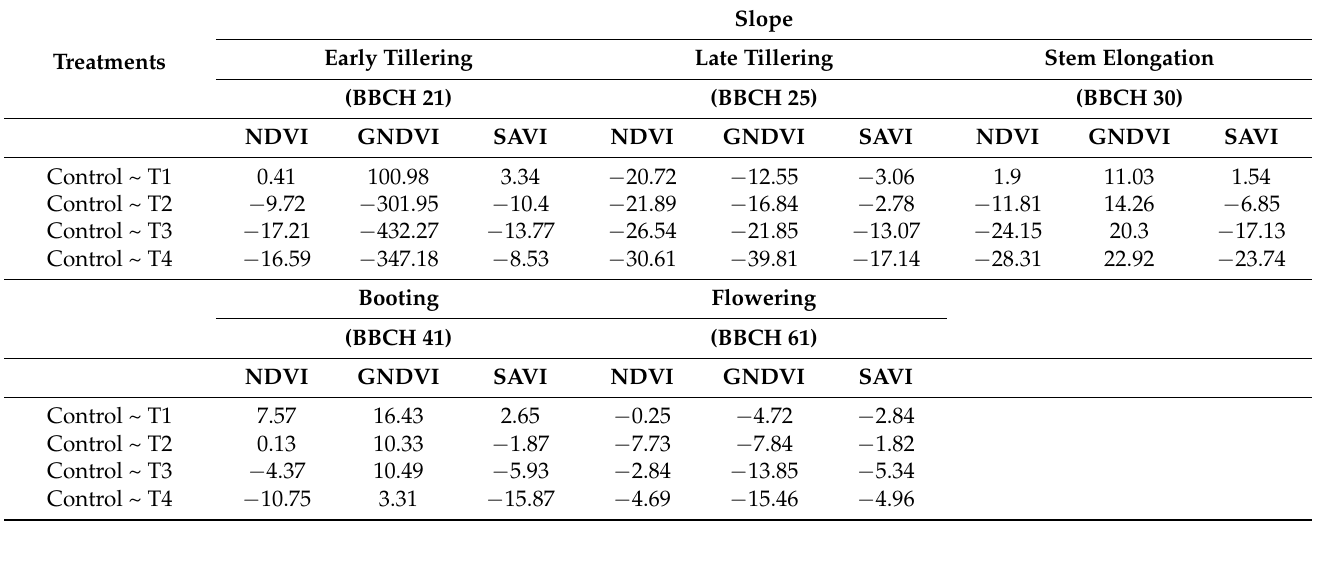
Figure A1. Images of ( a ) the chamber for toluene exposure simulation; ( b ) the rice five days after toluene exposure. Table A1. Supplementary data for sensitivity analysis results; slope values of the normalized difference vegetation index (NDVI), green normalized difference vegetation index (GNDVI), and soil-adjusted vegetation index (SAVI) at each growth stage.